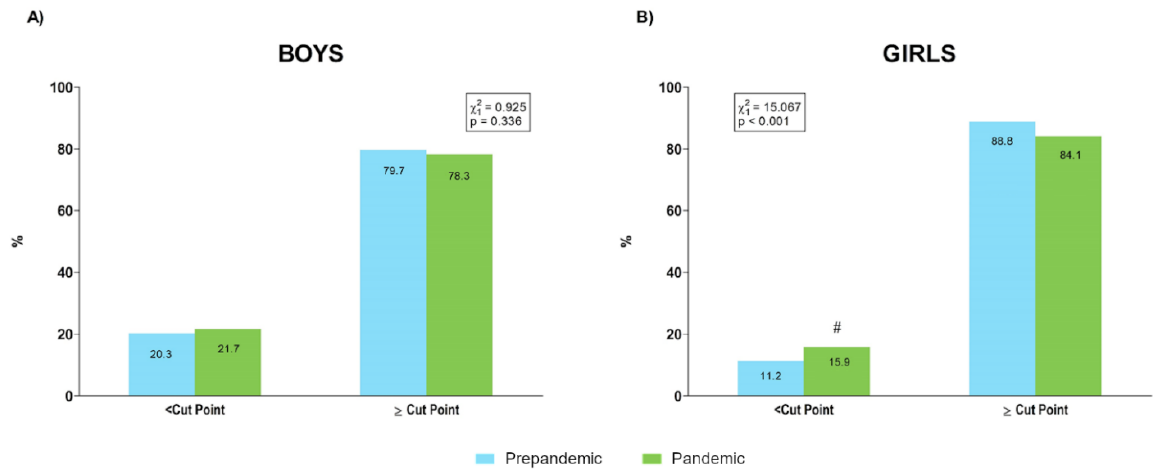
Figure 8. Percentage of boys ( A ) and girls ( B ) over and under cardiovascular risk standing long jump performance cut points [34] before and during the pandemic. #: absolute value of the standardized residual ≥ 2 for this category.